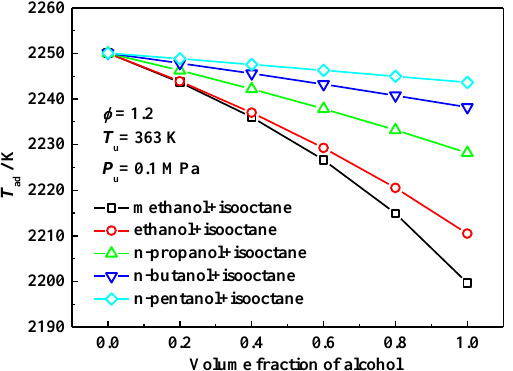
Figure 4. Adiabatic temperature of alcohol-isooctane blends vs. volume fraction of alcohol at 363 K, 0.1 MPa and the equivalence ratio of 1.2.